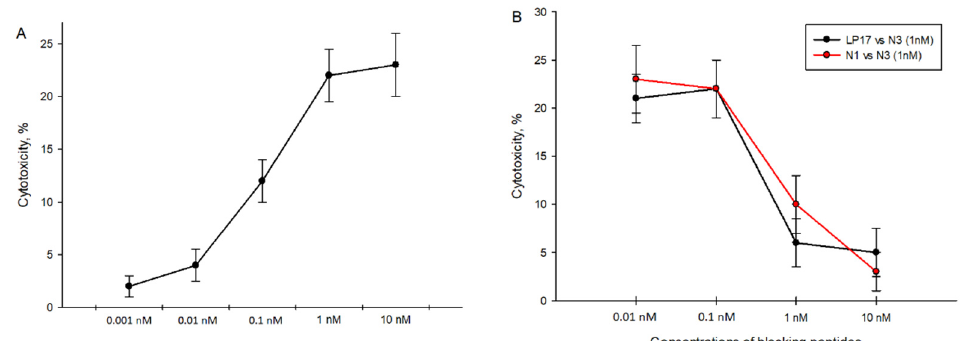
Figure 4. Cytotoxicity of N3-activated PBMCs against K562 cells. ( A ) N3-activated PBMC cytotoxicity depends on different concentrations of N3 peptides. ( B ) Cytotoxicity of N3-activated PBMCs in presence of TREM-1 inhibitory peptides: LP17 and N1. Concentration of N3 is constant in all cases—